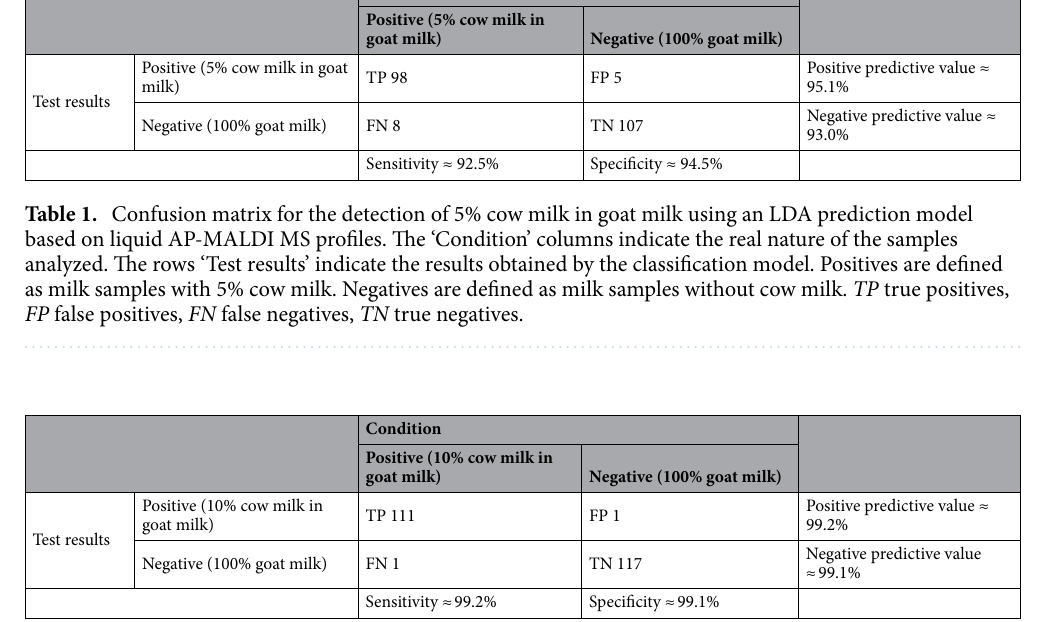
Table 2. Confusion matrix for the detection of 10% cow milk in goat milk using an LDA prediction model based on liquid AP-MALDI MS profiles. The ‘Condition’ columns indicate the real nature of the samples analyzed. The rows ‘Test results’ indicate the results obtained by the classification model. Positives are defined as milk samples with 10% cow milk. Negatives are defined as milk samples without cow milk. TP true positives, FP false positives, FN false negatives, TN true